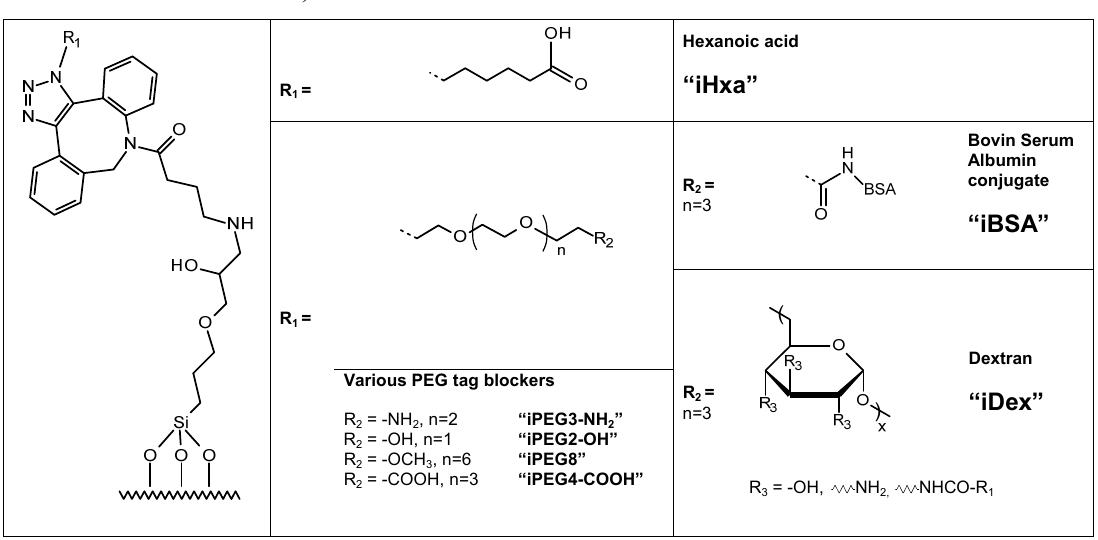
Table 2. Overview of surface immobilized blocking reagents used to study efficacy in reducing IgG induced NSB to modified microarray surfaces (prefix “i” denotes an “immobilized”